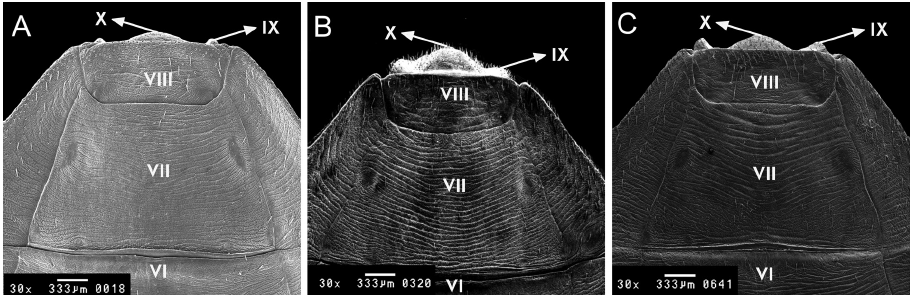
Figure 9. Female external genitalia, dorsal side of R. marabaensis sp. n. ( A ), R. prolixus ( B ), R. robustus ( C ). VI, VII, VIII, IX, X, tergites.